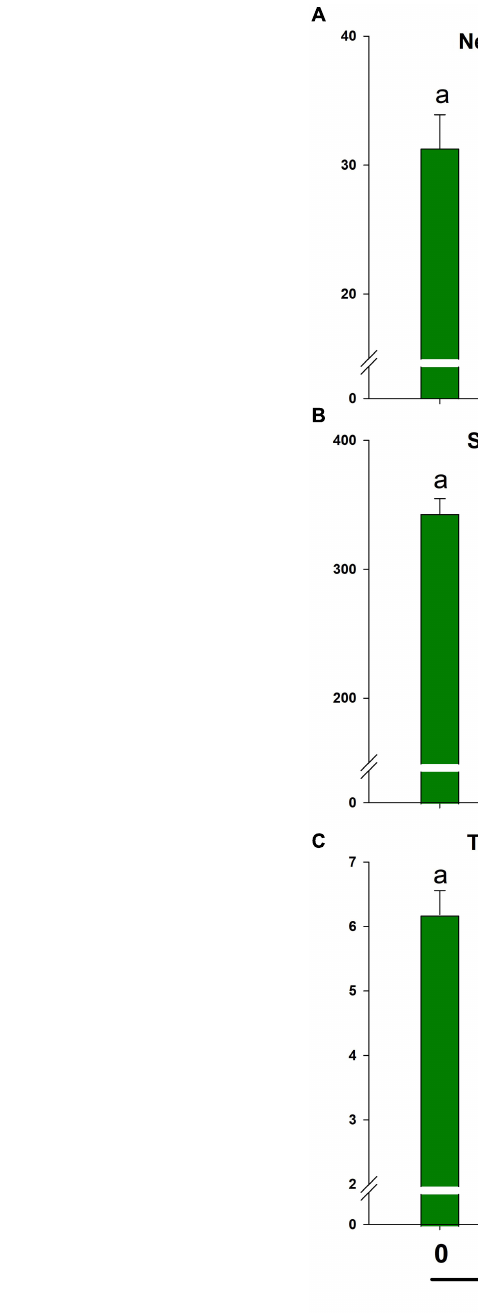
Frontiers in Plant Science |